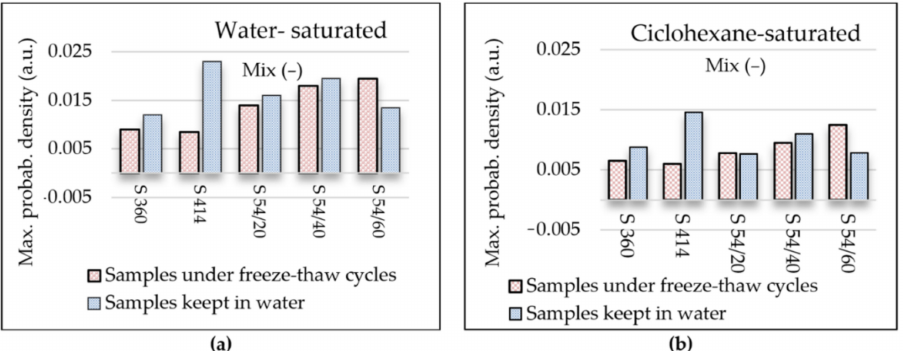
Figure 7. Maximum value of the probability density corresponding to the gel pores in the case of water saturated ( a ) and cyclohexane saturated ( b )